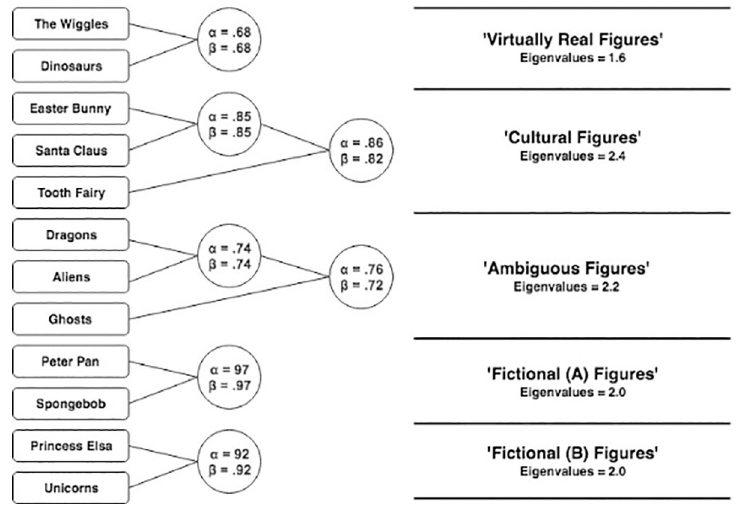
Fig 1. A 5-cluster solution of the child’s